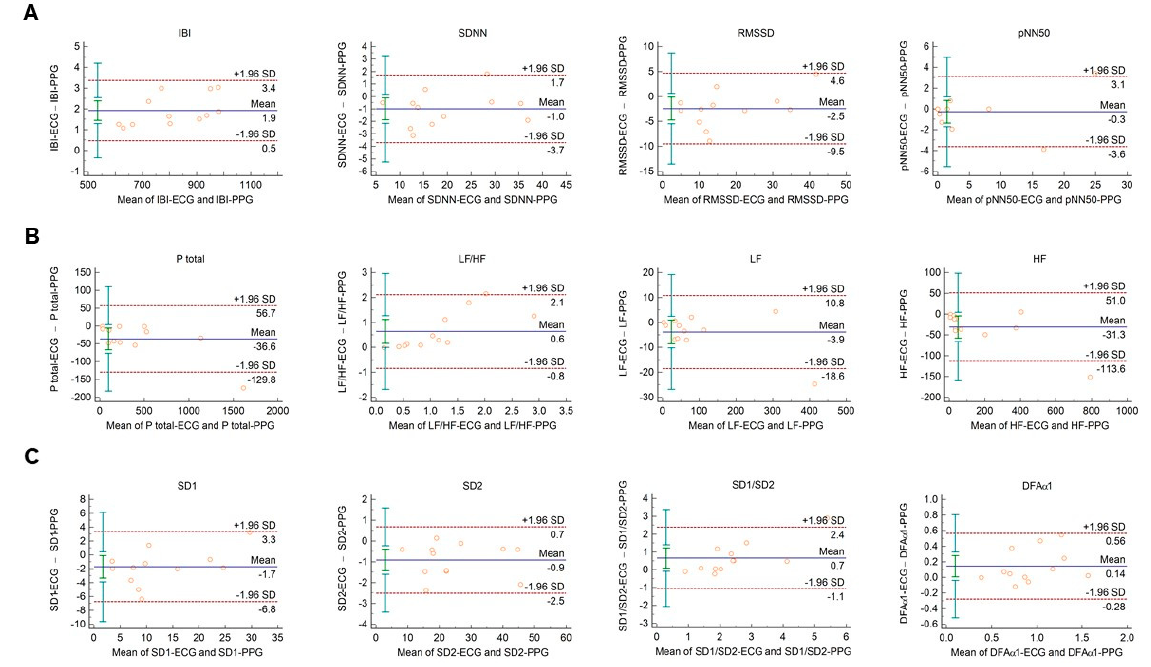
Figure 3. Bland–Altman plots of HRV/PRV parameters computed by the Kubios Premium algorithm from 2-min long ECG (indicated as ‘parameter name-ECG’) and PPG (indicated as ‘parameter name-PPG’) recordings obtained from diabetic patients under resting conditions. ( A ) Time-domain parameters: IBI (interbeat interval), SDNN (the standard deviation of IBIs), RMSSD (the square root of the mean squared differences of successive IBIs), pNN50 (the proportion of differences of successive IBIs exceeding 50 ms). ( B ) Frequency-domain parameters: Ptotal (total spectral power), LF/HF (ratio of low frequency to high frequency), LF (absolute power of the low-frequency band (0.04–0.15 Hz)), HF (absolute power of the high-frequency band (0.15–0.4 Hz)). ( C ) Non-linear parameters: SD1 (Poincaré plot standard deviation perpendicular to the line of identity), SD2 (Poincaré plot standard deviation along the line of identity), SD1/SD2 (ratio of SD1-to-SD2), DFA α 1 (short-term fluctuation slope obtained by detrended fluctuation analysis). Bias is calculated as the mean of differences (indicated as ‘Mean’—blue solid line) and is presented with 95% confidence intervals (green) and +/ − 1.96 standard deviations (SD) and their confidence intervals.